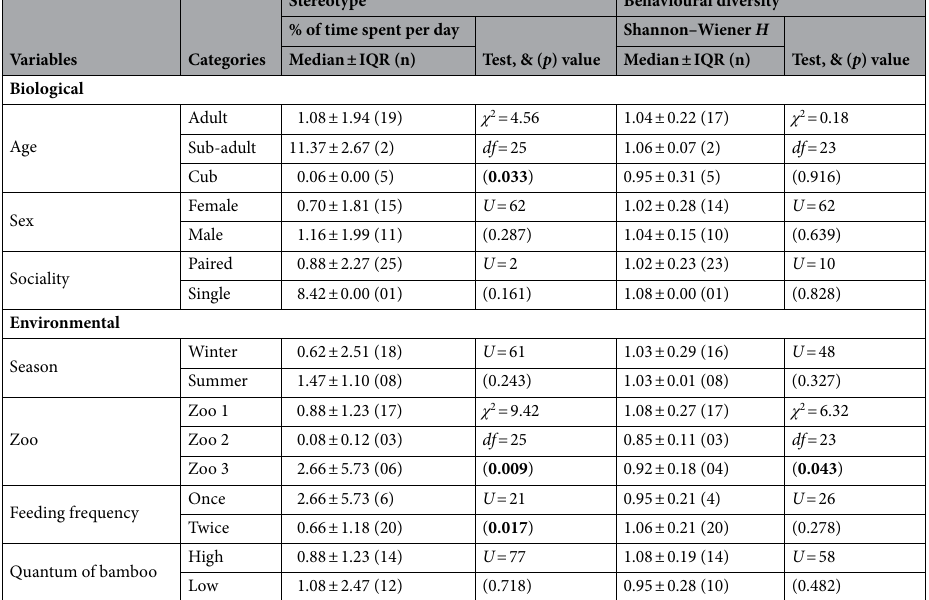
Table 1. Extent of stereotypy and behavioural diversity in relation to biological and environmental factors among captive pandas (n = 26 and n = 24 respectively) in Indian zoos: univariate analysis. For more detailed definitions of variables, see Table 5. U and χ 2 indicate the test statistics from the Mann–Whitney U and Kruskal–Wallis H tests respectively; df is degrees of freedom and IQR is interquartile range. Variables showing significant effects are highlighted. Significant values are in bold.